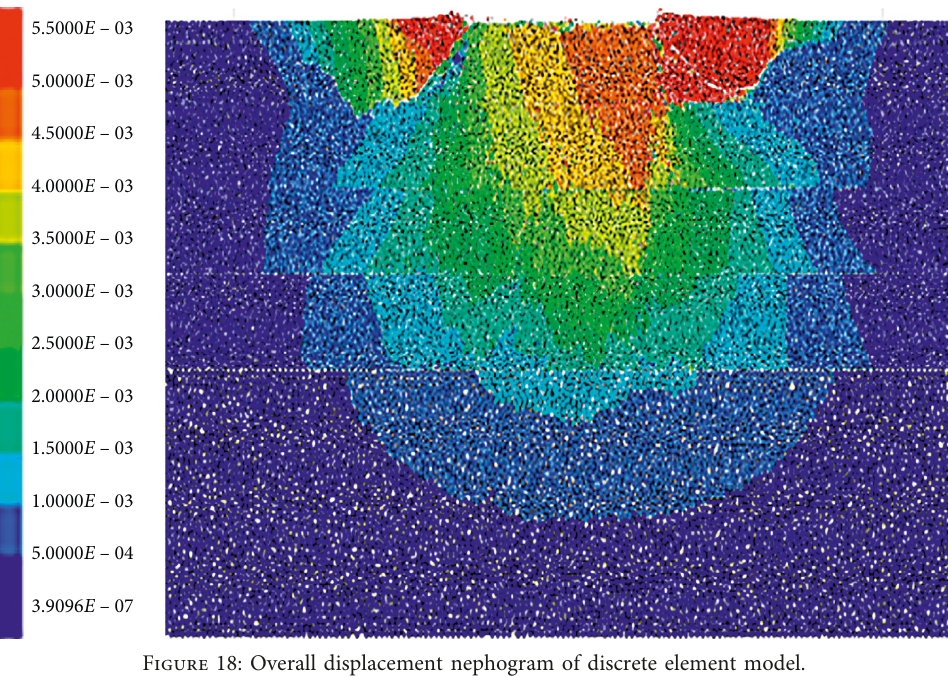
Figure 18: Overall displacement nephogram of discrete element model.